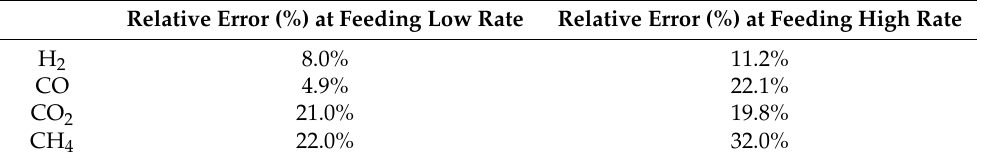
Table 7. Relative error between the experimental and simulative results. Relative Error (%) at Feeding Low Rate Relative Error (%) at Feeding High